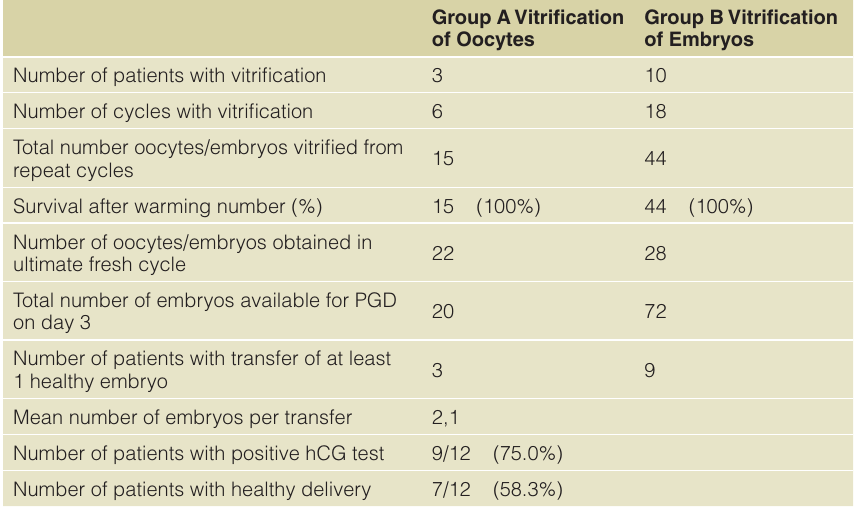
Table 1. Clinical and laboratory outcomes for poor responder PGD patients after serial vitrification of oocytes or